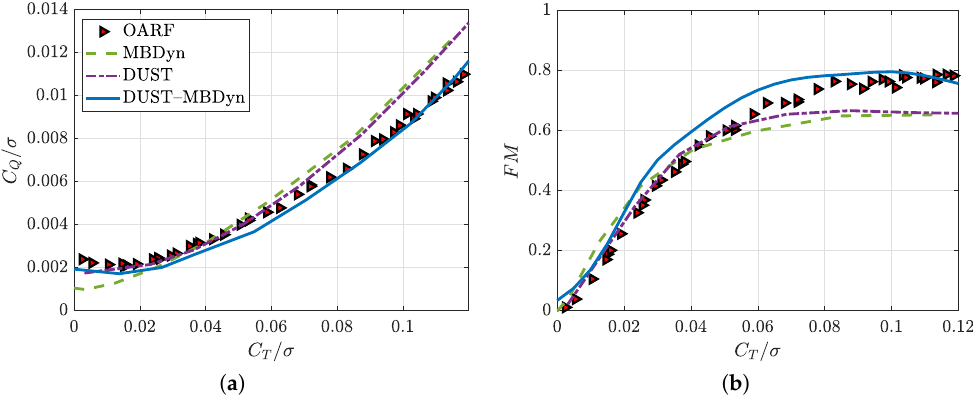
Figure 12. Comparison of results obtained for the XV-15 full-scale single proprotor in hover: ( a ) torque coefficient C Q / σ versus thrust coefficient C T / σ ; ( b ) figure of merit (FM) versus thrust coefficient C T / σ